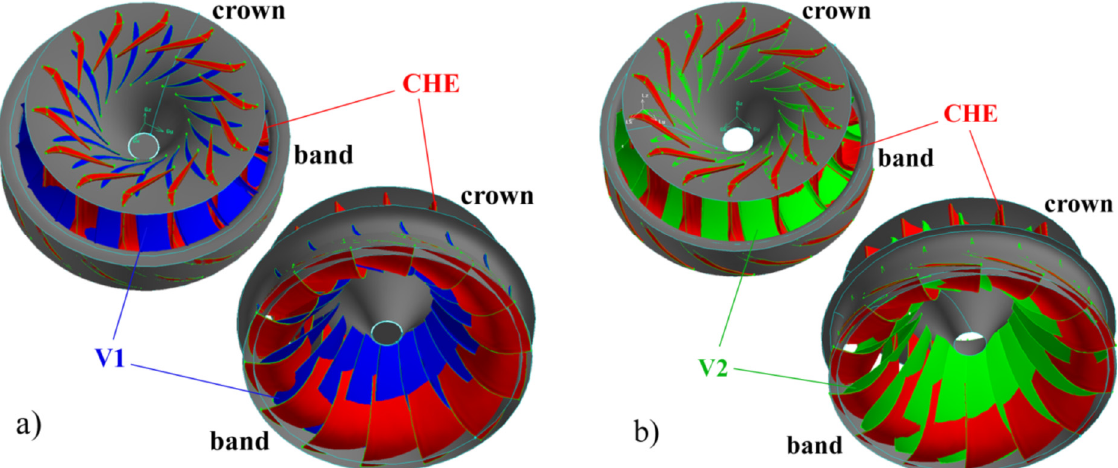
Fig. 3. New runner geometries with 17 blades against old runner geometry with 14 blades available in the hydropower plant (red): (a) V1 (blue) and (b) V2 (green).